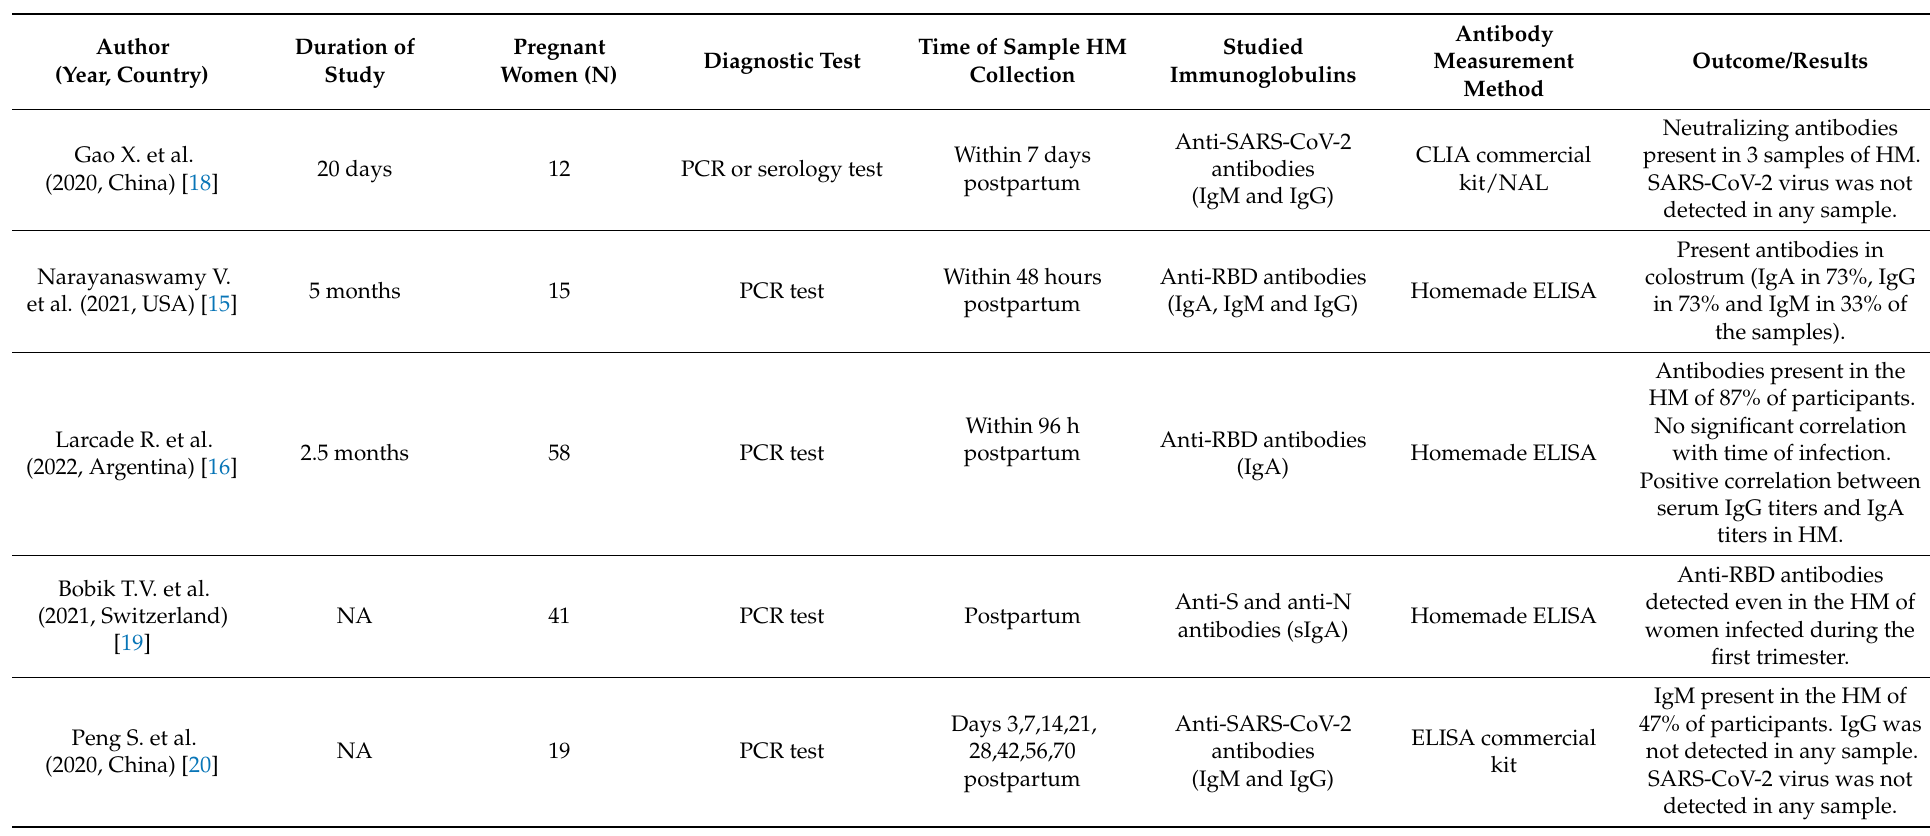
Table 1. Characteristics of included studies referring to first-time-infected pregnant